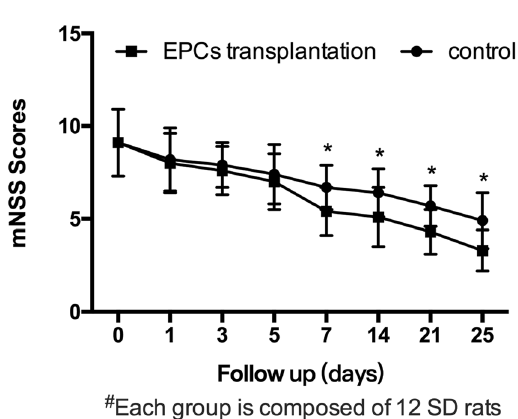
Figure 10. Neurobehavioral tests. The mNSS test was performed in the control and EPCs-treated groups (12 rats in each group). Neurological function was evaluated by mNSS prior to and 1 st , 3 rd , 5 th , 7 th , 14 th , 21 st , and 25 th days in the control and EPC-transplanted rats after TBI. Quantification of mNSS test results showed that the EPC treatment improved neurofunctional outcomes. * P < 0.05 versus the control group. Data are presented as means ±